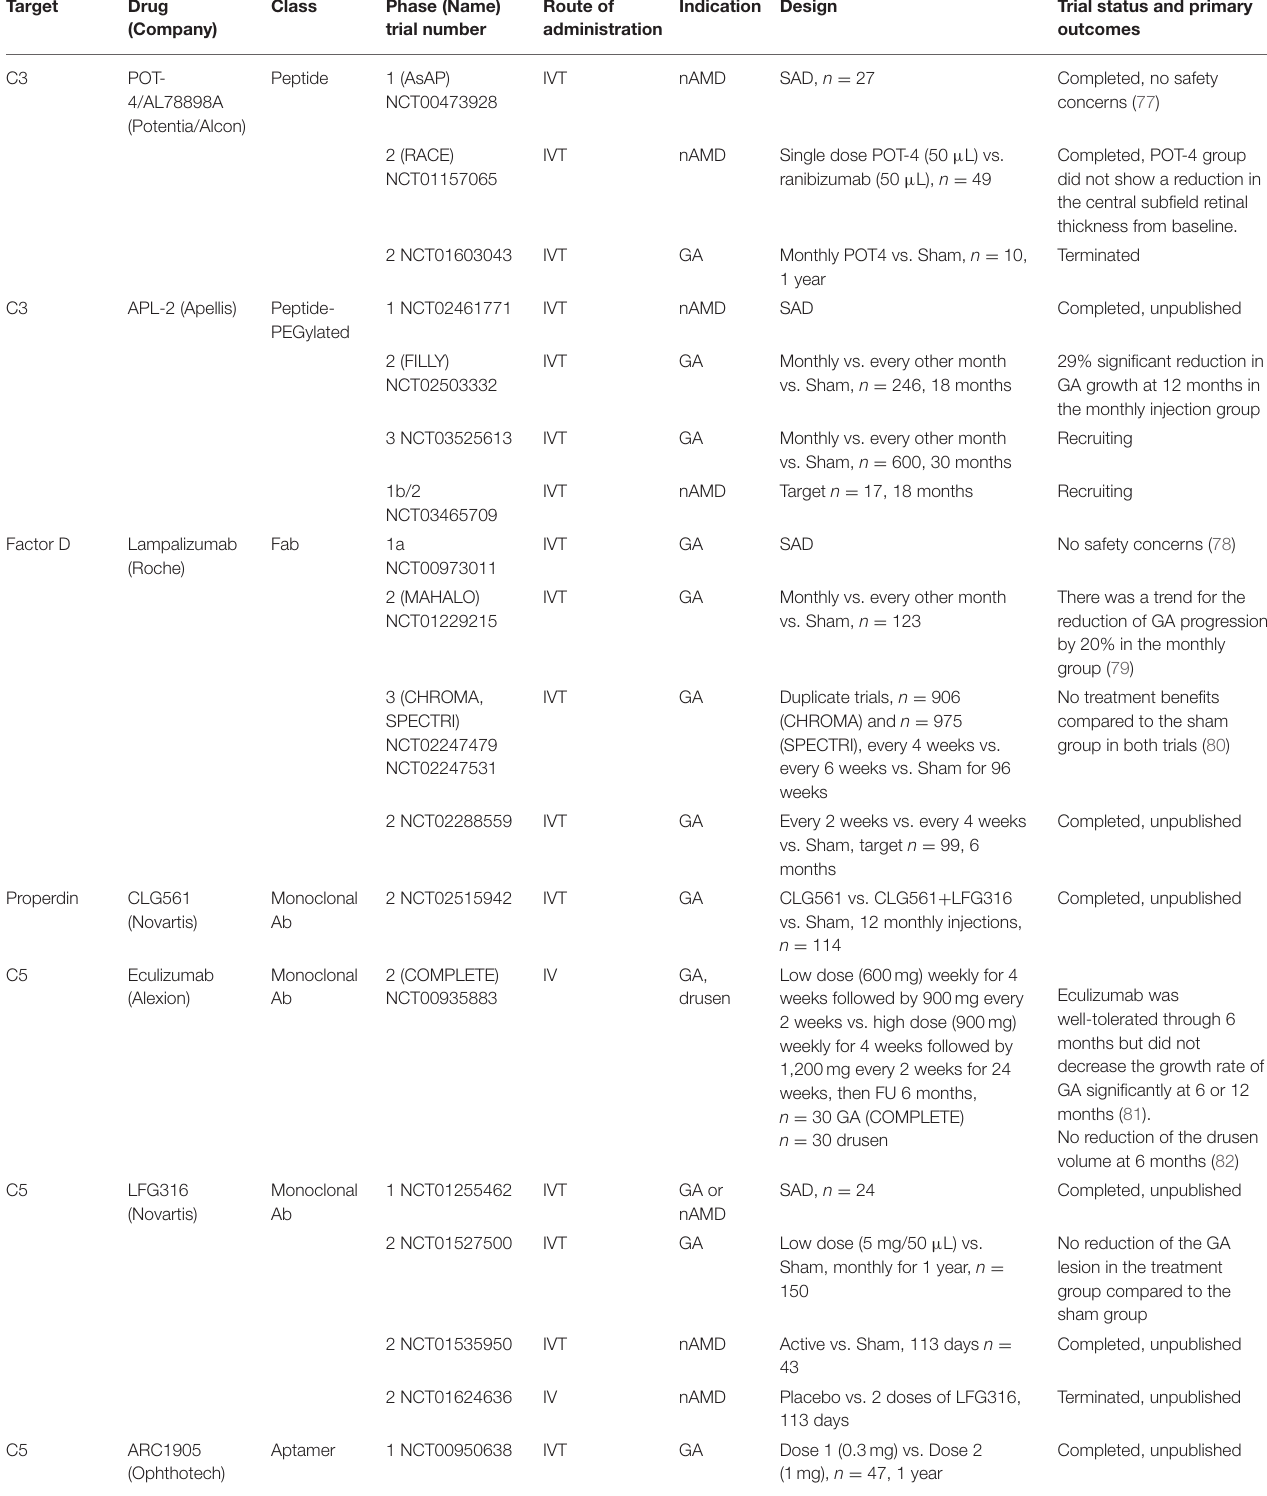
TABLE 2 | Complement-mediated therapeutics in clinical trials for the treatment of age-related macular degeneration.